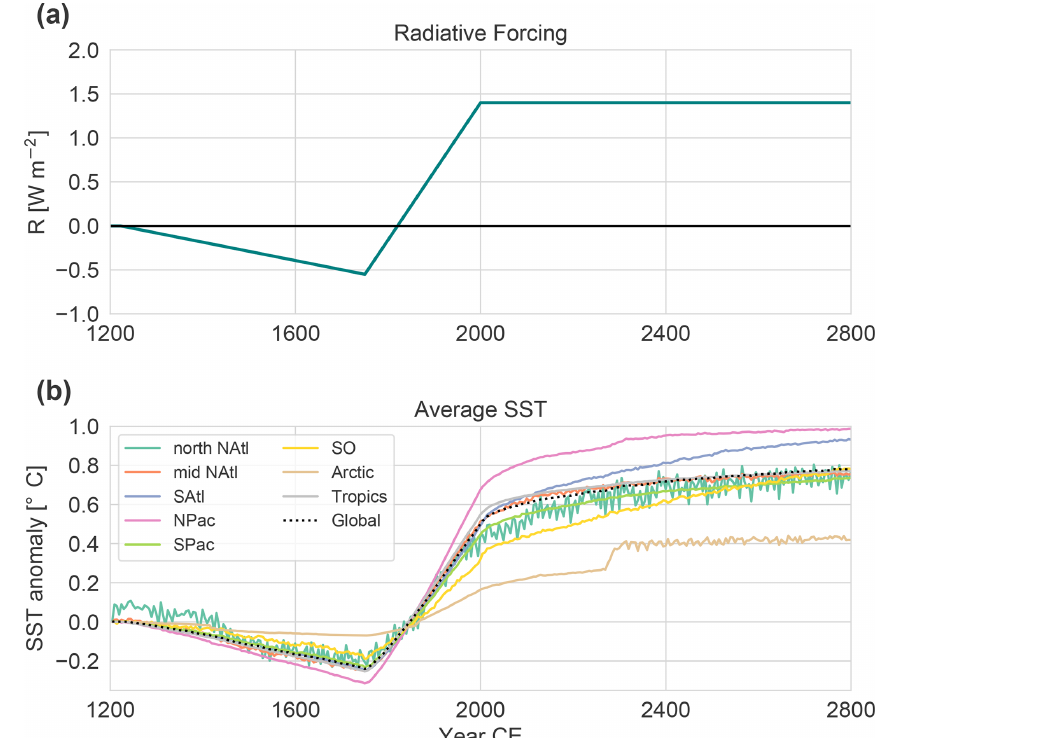
Figure 1. (a) Idealized radiative forcing, which is used in the case of coupled simulations (OcAtmTRA and OcAtmFIX; see Table 1). (b) Sea surface temperature anomaly as a result of the forcing in (a) : globally (black, dotted line) and averaged per region (colours, defined in Fig. A1). The global average SST at 1200CE is 18.0 ◦